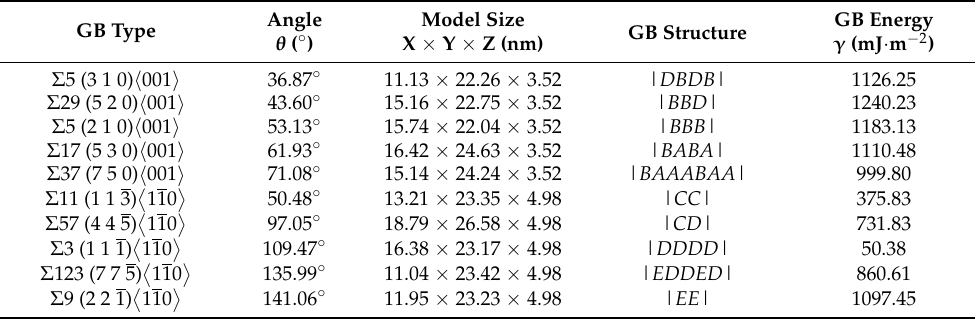
Figure 1. Schematic illustration of the STGB with tilt axis along the Z direction and the normal to the boundary plane along the Y direction. Table 1. Characterization of all considered GBs, including the model size, misorientation angle ( θ ) , GB structure unit, and GB energy γ (mJ · m − 2 ).